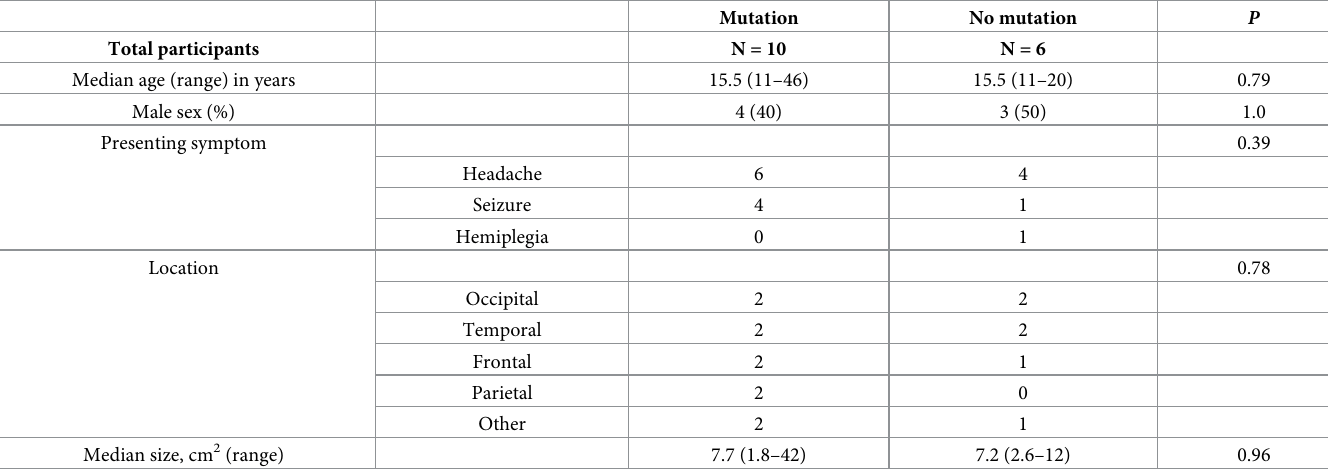
Table 2. Patient characteristics grouped by mutation